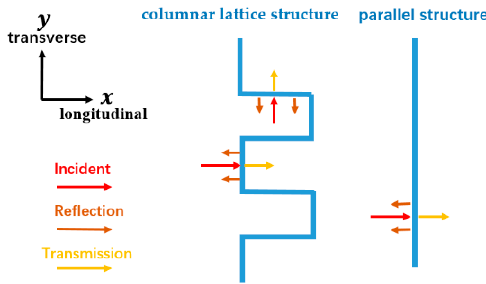
Figure 5. Reflection and transmission of plane stress waves on the interface.